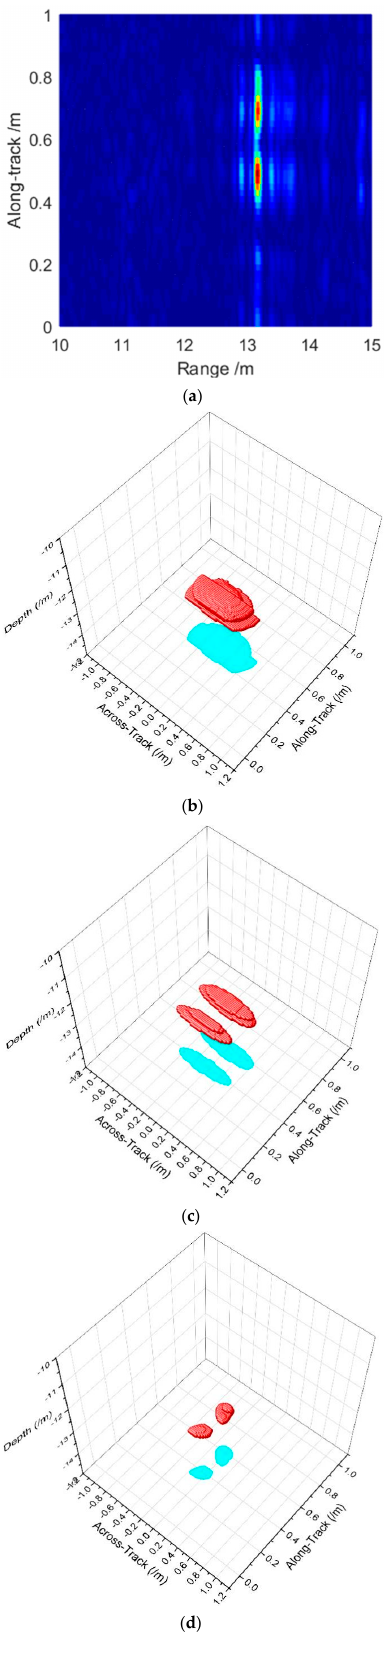
Figure 12. Imaging comparison between different methods: ( a ) 2D imaging result of SAS; ( b ) imaging result of MBES; ( c ) imaging result of MBSAS with CBF in the across-track direction; and ( d ) imaging result of MBSAS with accelerated deconvolved beamforming in the across-track direction.